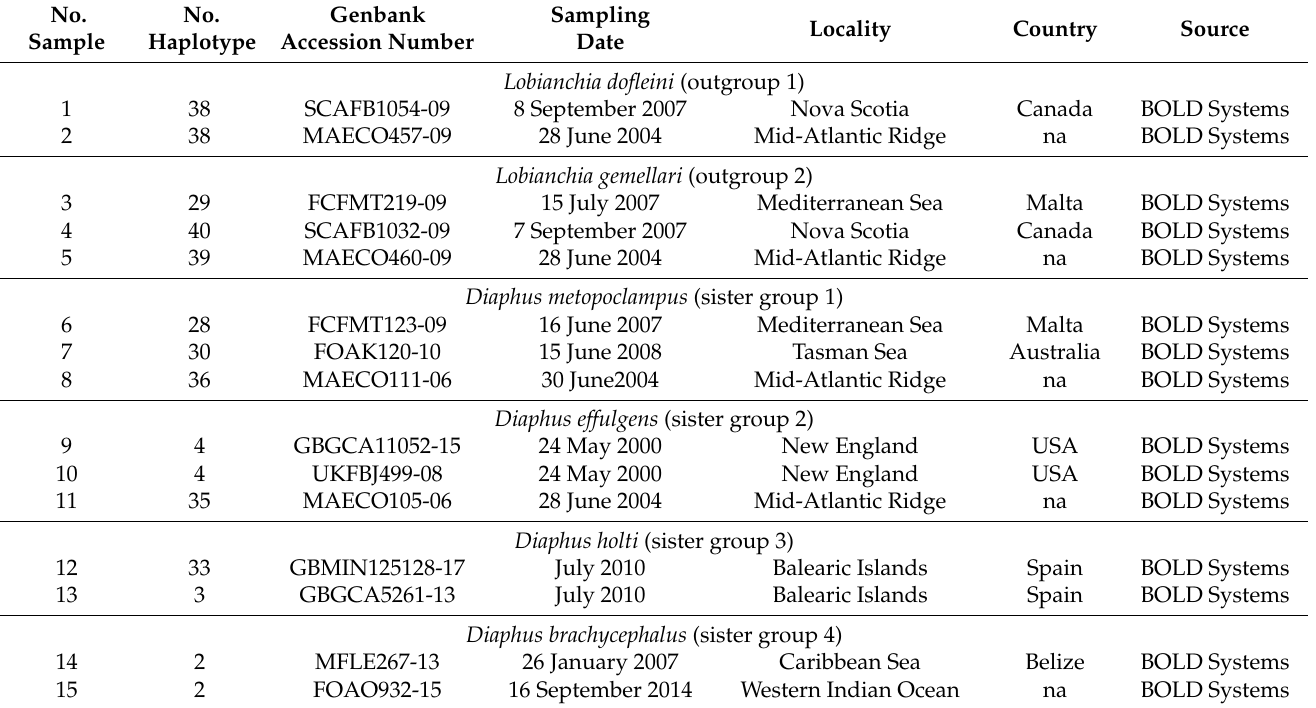
Table 1. Information about CO1 sequences and respective samples used for molecular analysis (na = not